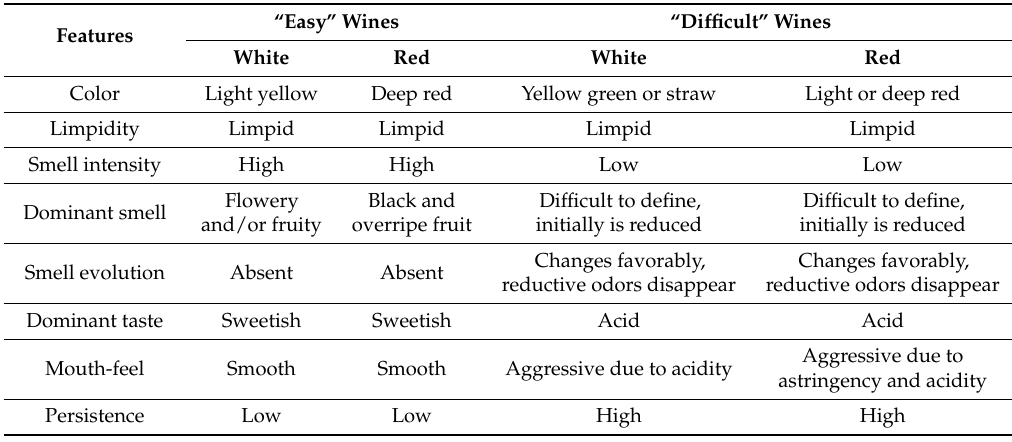
Table 3. Characteristics of the two opposite anchor wine styles used in the training sessions.